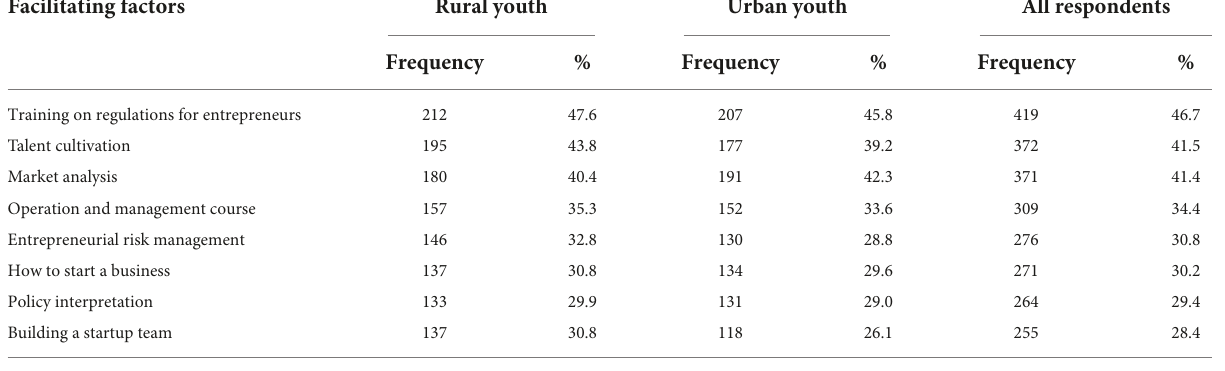
TABLE 15 Startup